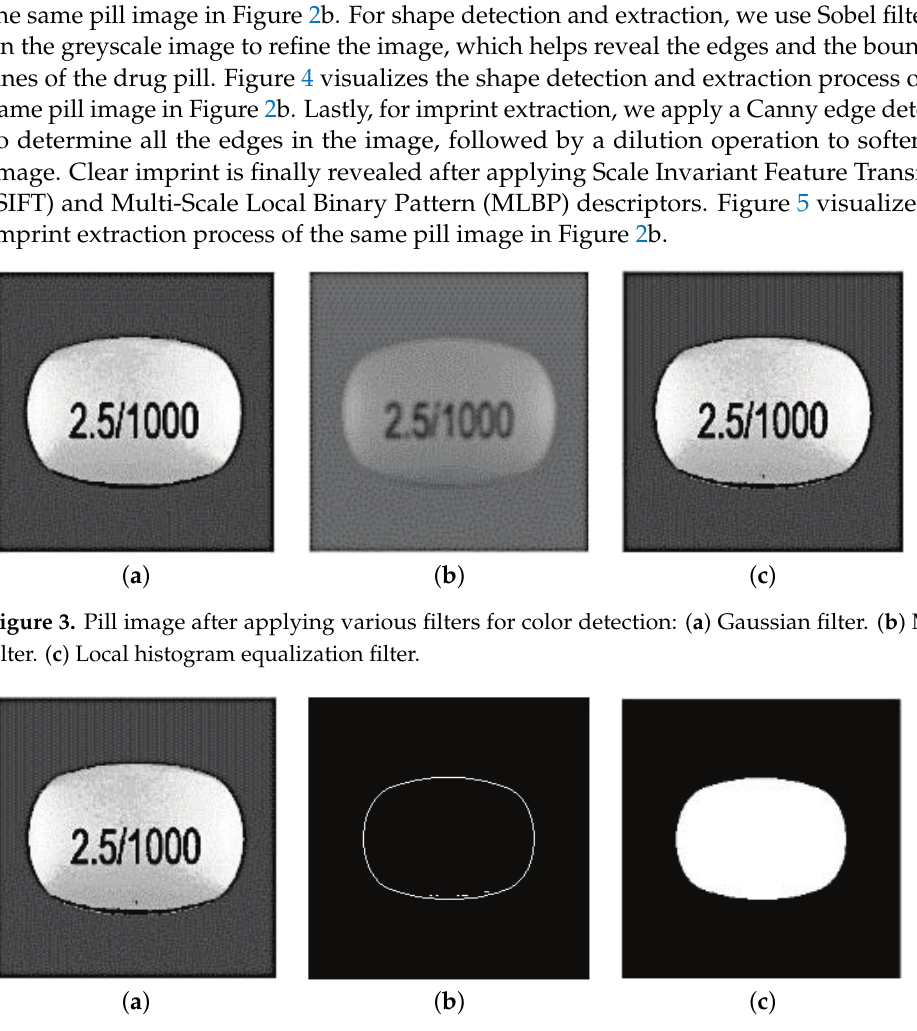
Figure 4. Pill image after applying various filters for shape detection: ( a ) Local histogram equalization filter. ( b ) Sobel filter. ( c ) Segmented